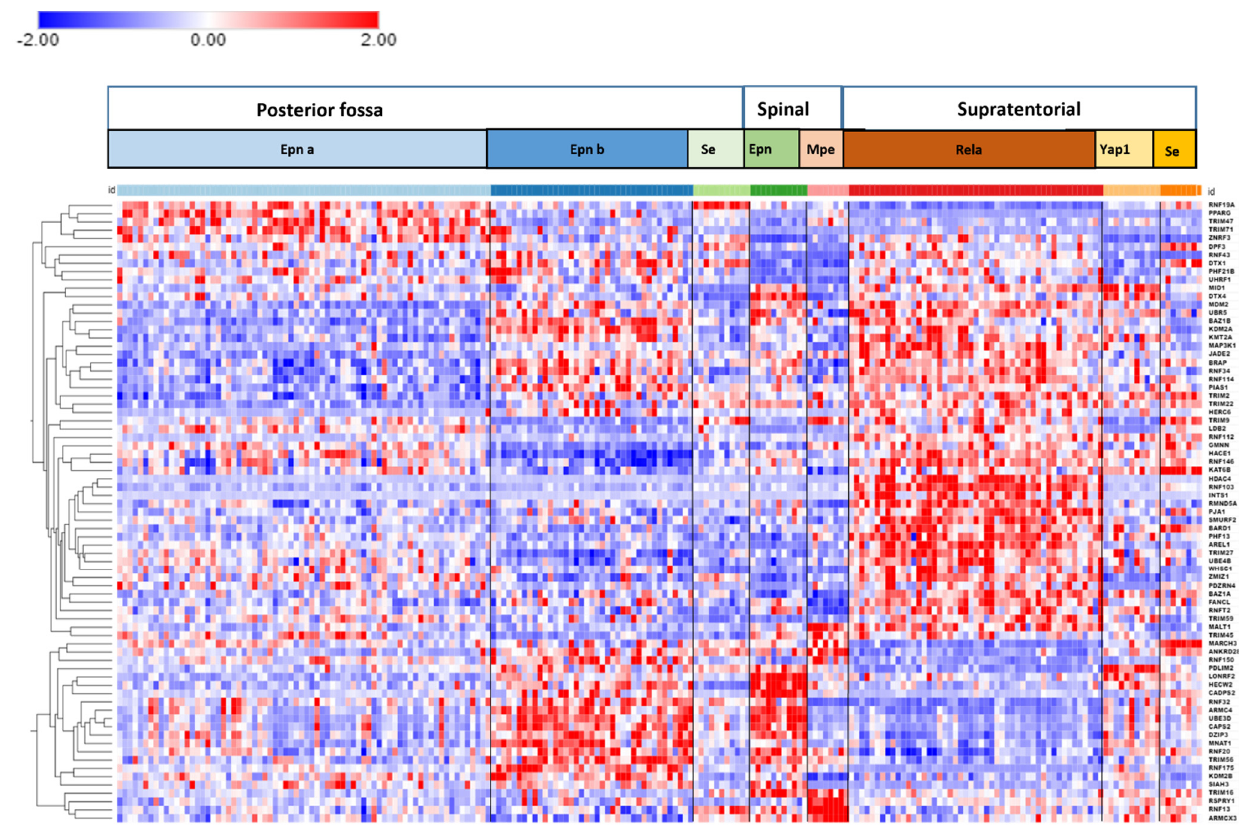
Figure 5. Cluster analysis of differentially expressed ubiquitin E3 ligase genes in different EPN subtypes. Genes are listed again in the order they appear in the heatmap (top to bottom) for better readability. Genes on the right of the heatmap are listed again for better visibility: RNF19A , PPARG , TRIM47 , TRIM71 , ZNRF3 , DPF3 , RNF43 , DTX1 , PHF21B , UHRF1 , MID1 , DTX4 , MDM2 , UBR5 , BAZ1B , KDM2A , KMT2A , MAP3K1 , JADE2 , BRAP , RNF34 , RNF114 , PIAS1 , TRIM2 , TRIM22 , HERC6 , TRIM9 , LDB2 , RNF112 , GMNN , HACE1 , RNF146 , KAT6B , HDAC4 , RNF103 , INTS1 , RMND5A , PJA1 , SMURF2 , BARD1 , PFH13 , AREL1 , TRIM27 , UBE4B , WHSC1 , ZMIZ1 , PDZRN4 , BAZ1A , FANCL